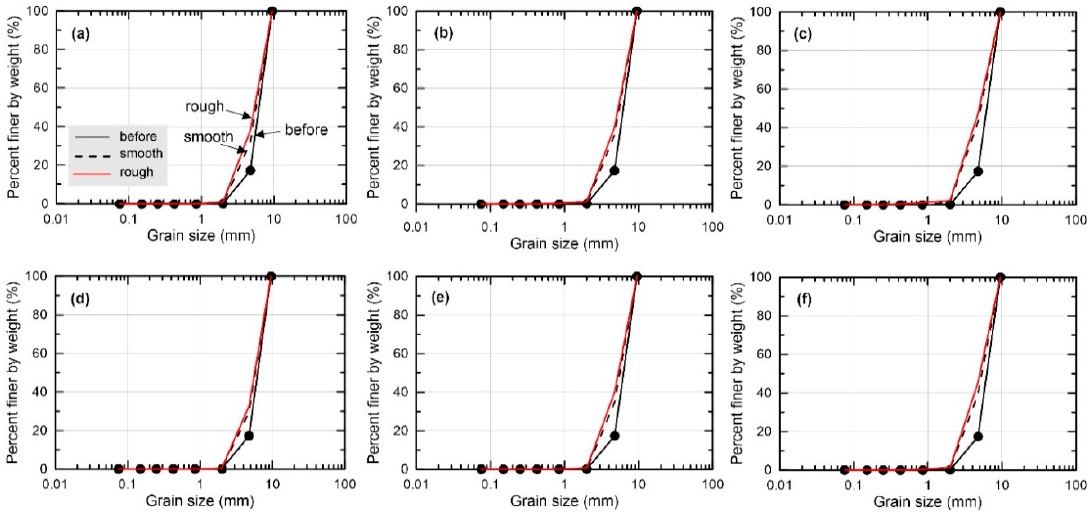
Figure 6. Grain crushing effect with respect to surface roughness: ( a – c ) Drained and ( d – f ) undrained conditions. ( a , d ): 0.1 mm/s; ( b , e ): 0.5 mm/s; and ( c , f ): 1 mm/s. conditions. ( a , d ): 0.1 mm / s; ( b , e ): 0.5 mm / s; and ( c , f ): 1 mm /